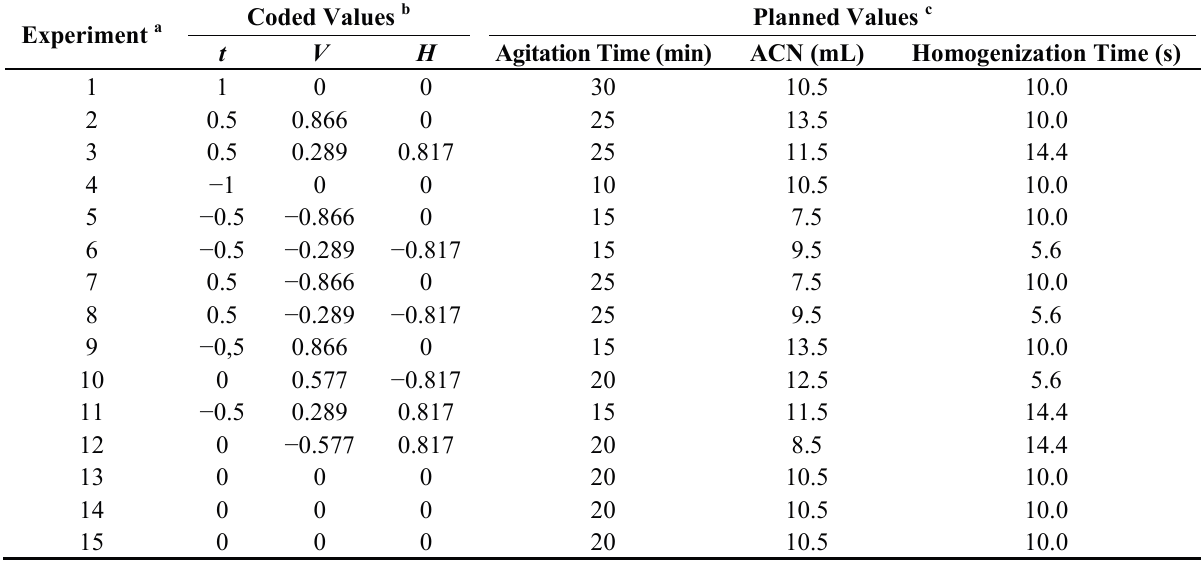
Table 2. Doehlert matrix for the variables used in sample preparation optimization. Experiment